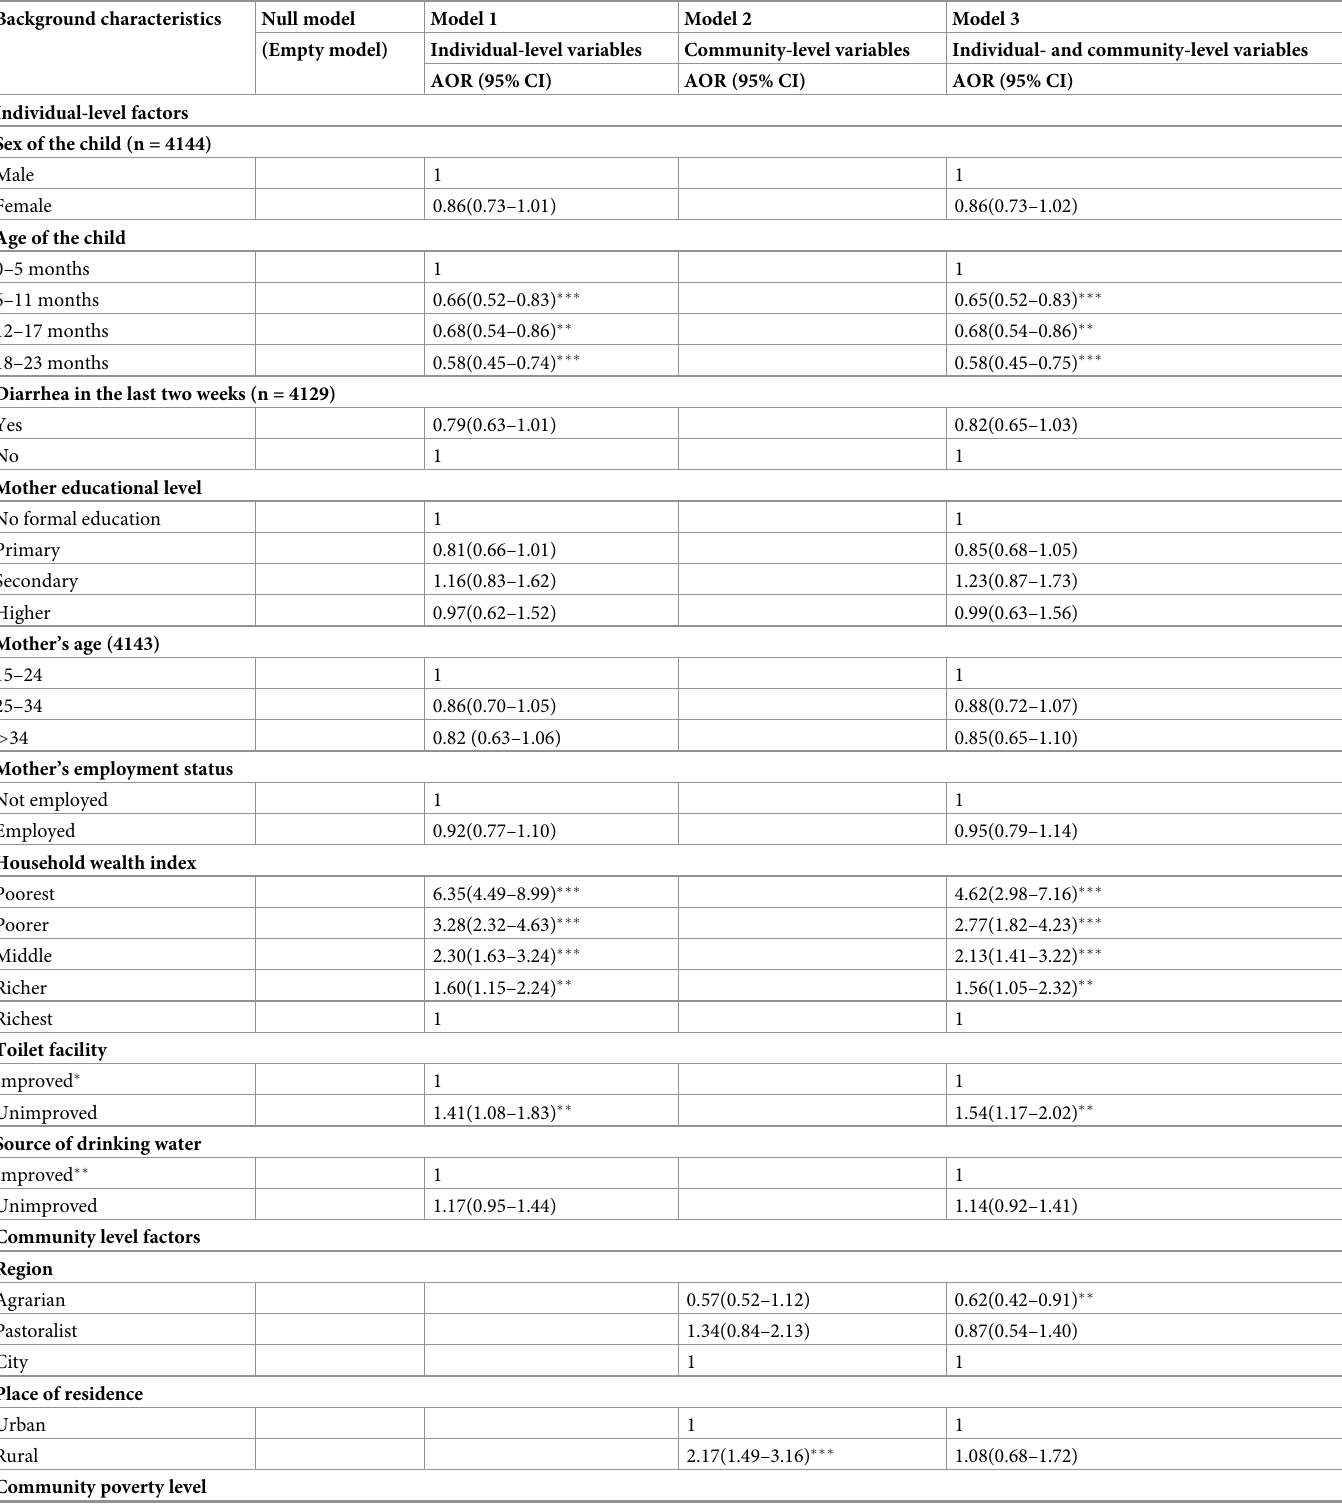
Table 6. Multivariable multilevel logistic regression analysis to determine associated factors of unsafe child stool disposal in Ethiopia, EDHS